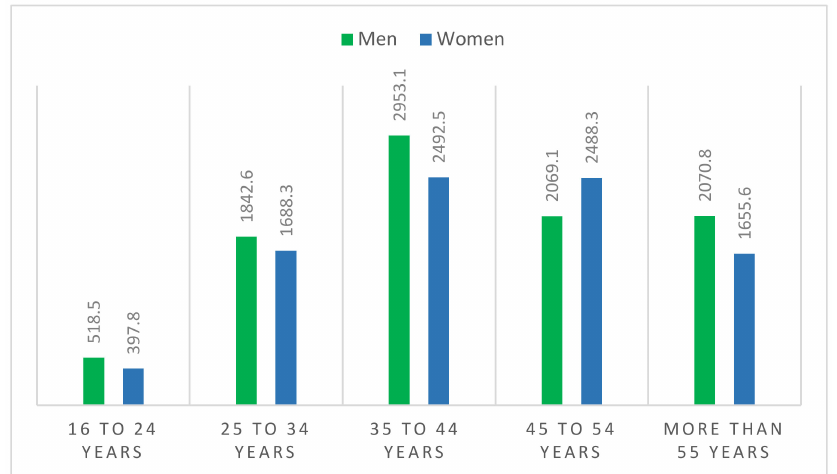
Figure 5. Employment by sex and age (thousands of people, 2020). Source: Own elaboration from data of the Spanish National Statistics Institute (INE)